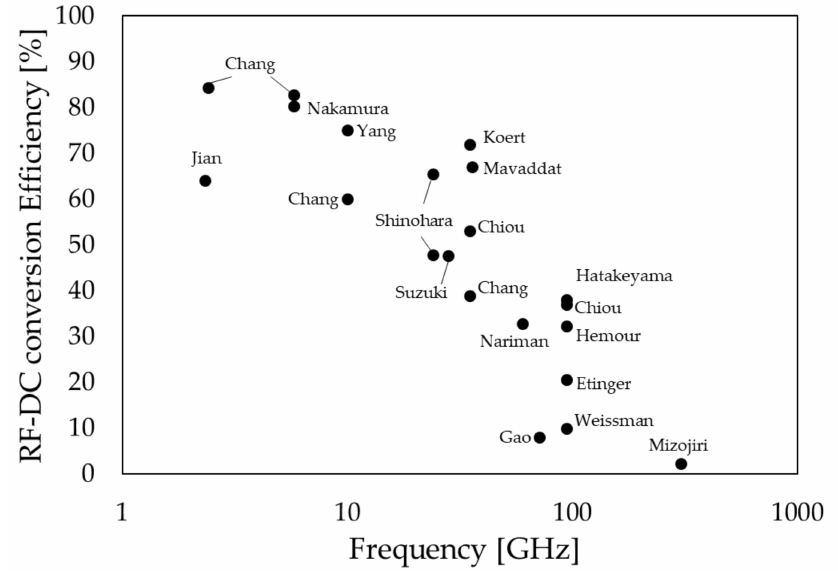
Figure 1. Earlier reports of studies examining rectenna RF–DC conversion efficiency for frequency [2–10,13–18,22–24].